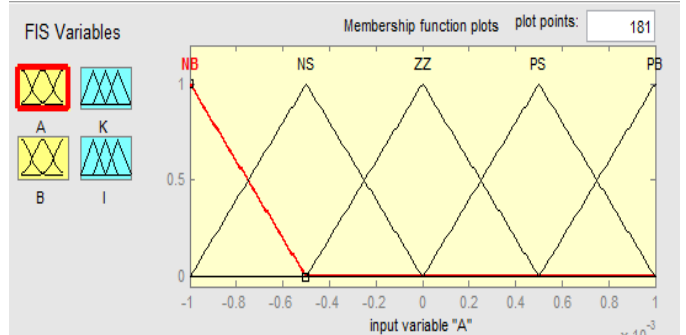
Figure 7. Membership functions.